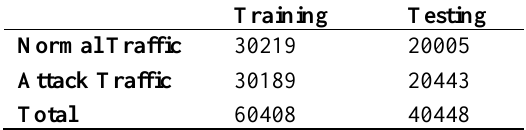
Table 6. Test Results of 27 attributes.